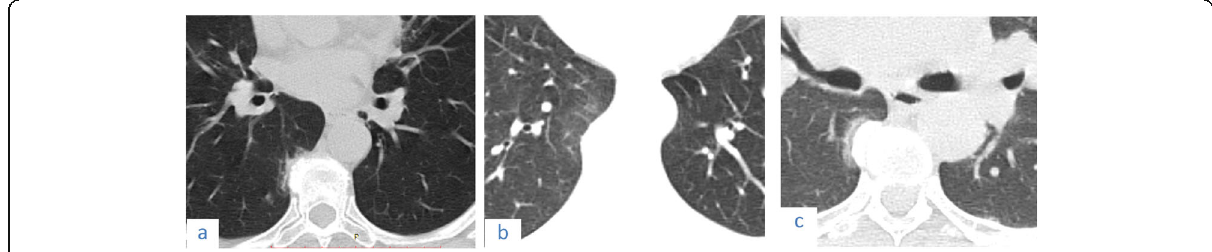
Fig. 22 Three cases of osteophyte induced adjacent pulmonary fibrosis and atelectasis are seen as right lower lobe subpleural ground glass opacification and reticulations adjacent to a dorsal spine exuberant osteophyte in ( a ) 57-year-old female, ( b ) 63-year-old female, and ( c ) female patient 48 years